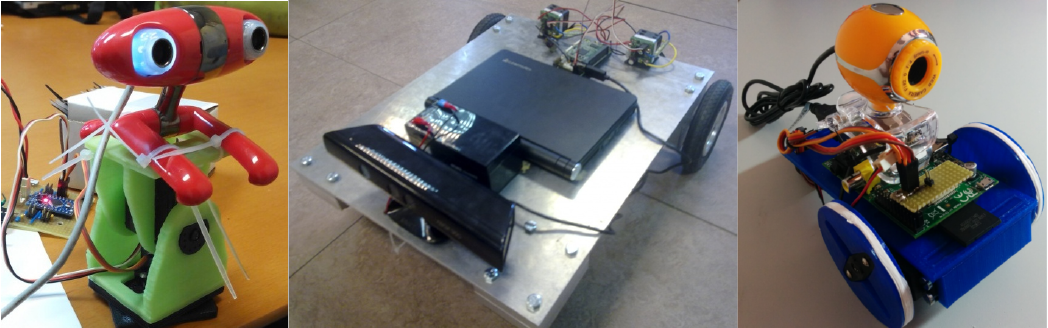
Fig. 5. Robot platforms tested with Robot Devastation: Gun turret is shown on the left, ECRO is the one in the middle image, and RD1 is the platform on the right.